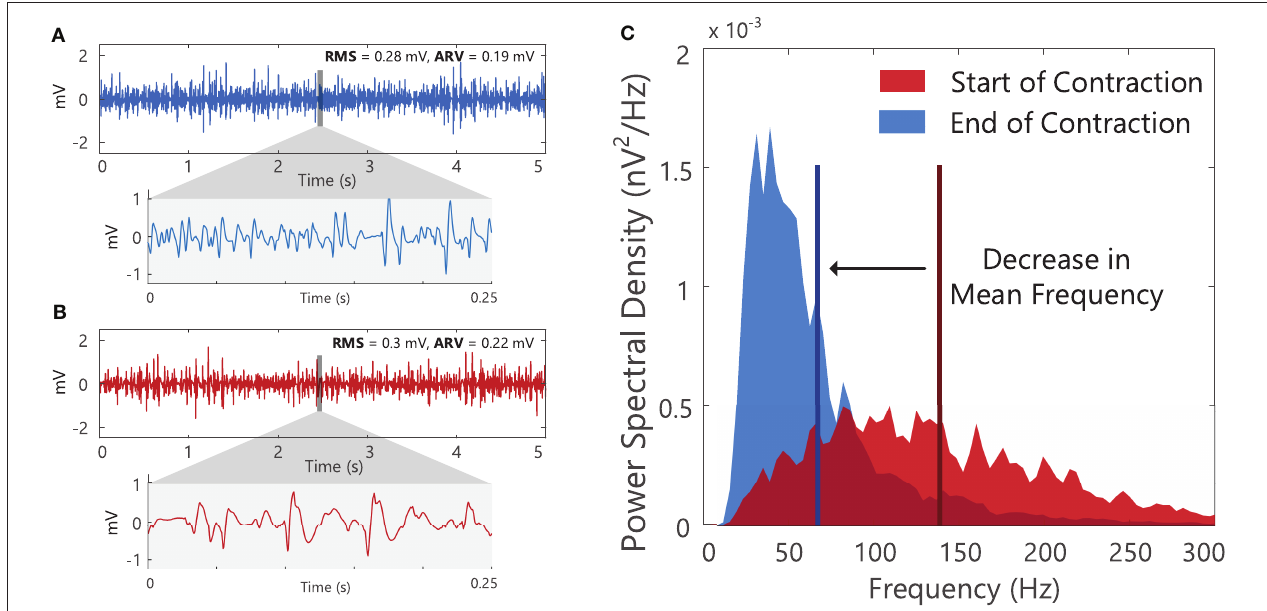
FIGURE 12 | A 5-s segment of surface EMG signal from at (A) the start and (B) the end of a fatiguing isometric contraction in the first dorsal interosseous muscle. With fatigue the duration of the motor unit action potential lengthens, and there is a shift in the surface EMG signal to lower frequencies. (C) The shape of the power spectral density of the surface EMG segments shown in (A) and (B) . A decrease in the mean frequency (vertical line) of the surface EMG signal is observed, accompanied by an increase in the surface EMG amplitude, see increase in RMS and ARV of the surface EMG amplitude in (B) . See Example (xvii) in Tutorial Code.